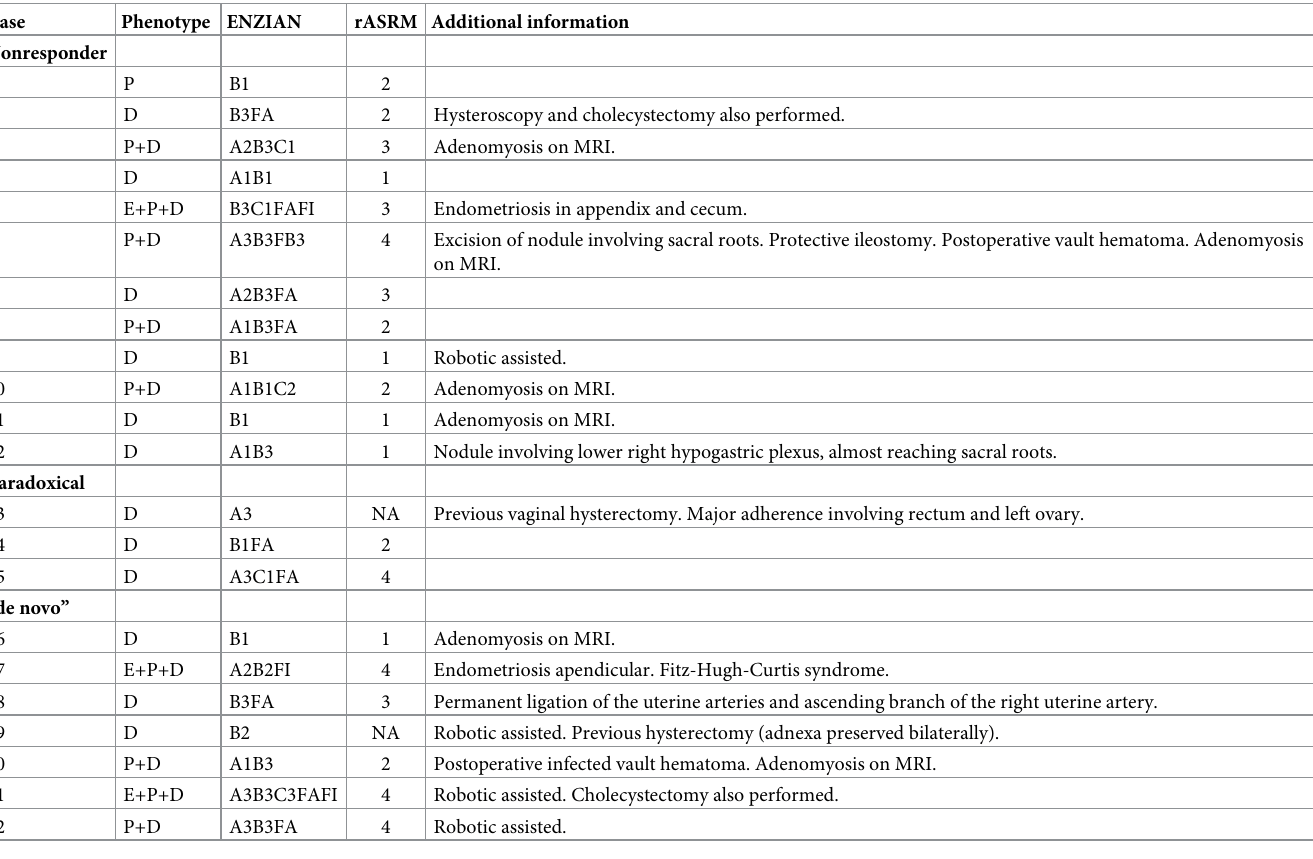
Table 5. Classification of endometriosis and specific comments about the surgery performed in the 22 women who were not considered responders for deep